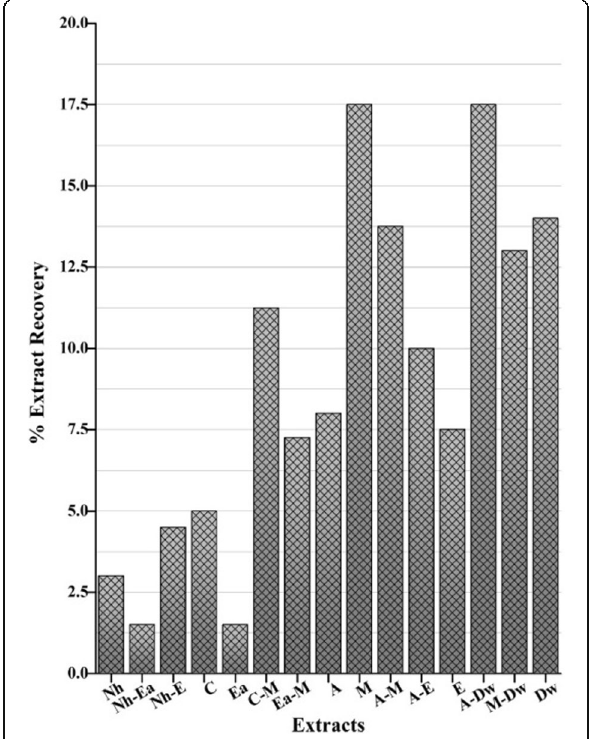
Fig. 1 Percent extract recovery of A. bracteosa using mono and binary (1:1) solvents for extraction. Nh: n-hexane, Nh-Ea: n-hexane- ethyl acetate, Nh-E: n-hexane-ethanol, C: chloroform, Ea: ethyl acetate, C-M: chloroform-methanol, Ea-M: ethyl acetate-methanol, A: acetone, M: methanol, A-M: acetone- methanol, A-E: acetone-ethanol, E: ethanol, A-Dw: acetone-distilled water, M-Dw: methanol-distilled water, Dw: distilled